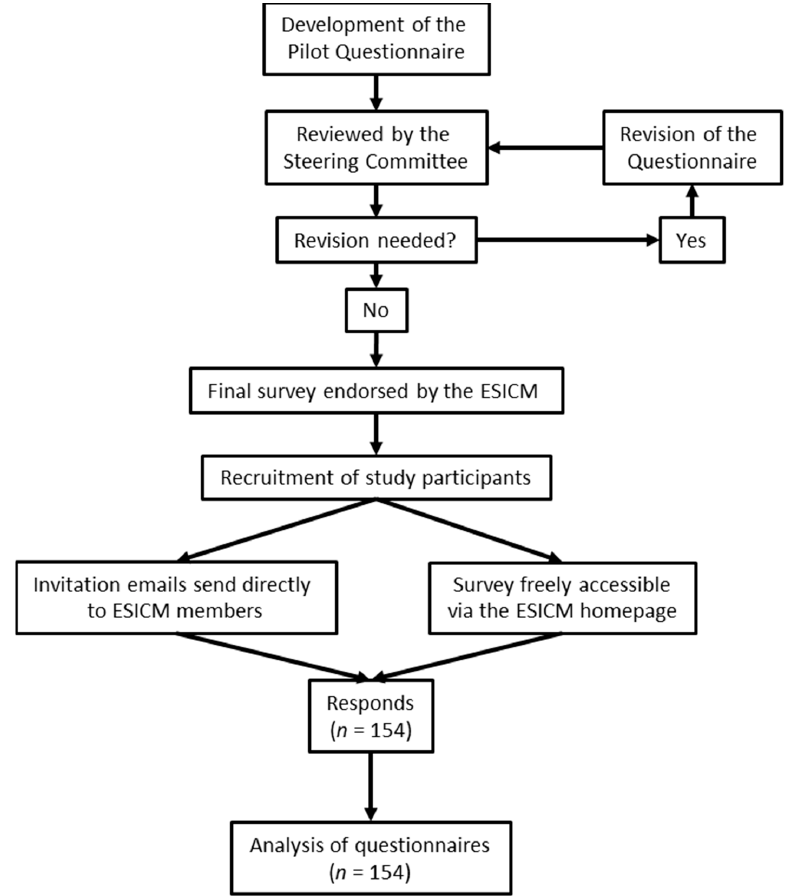
Figure 1. Study flow